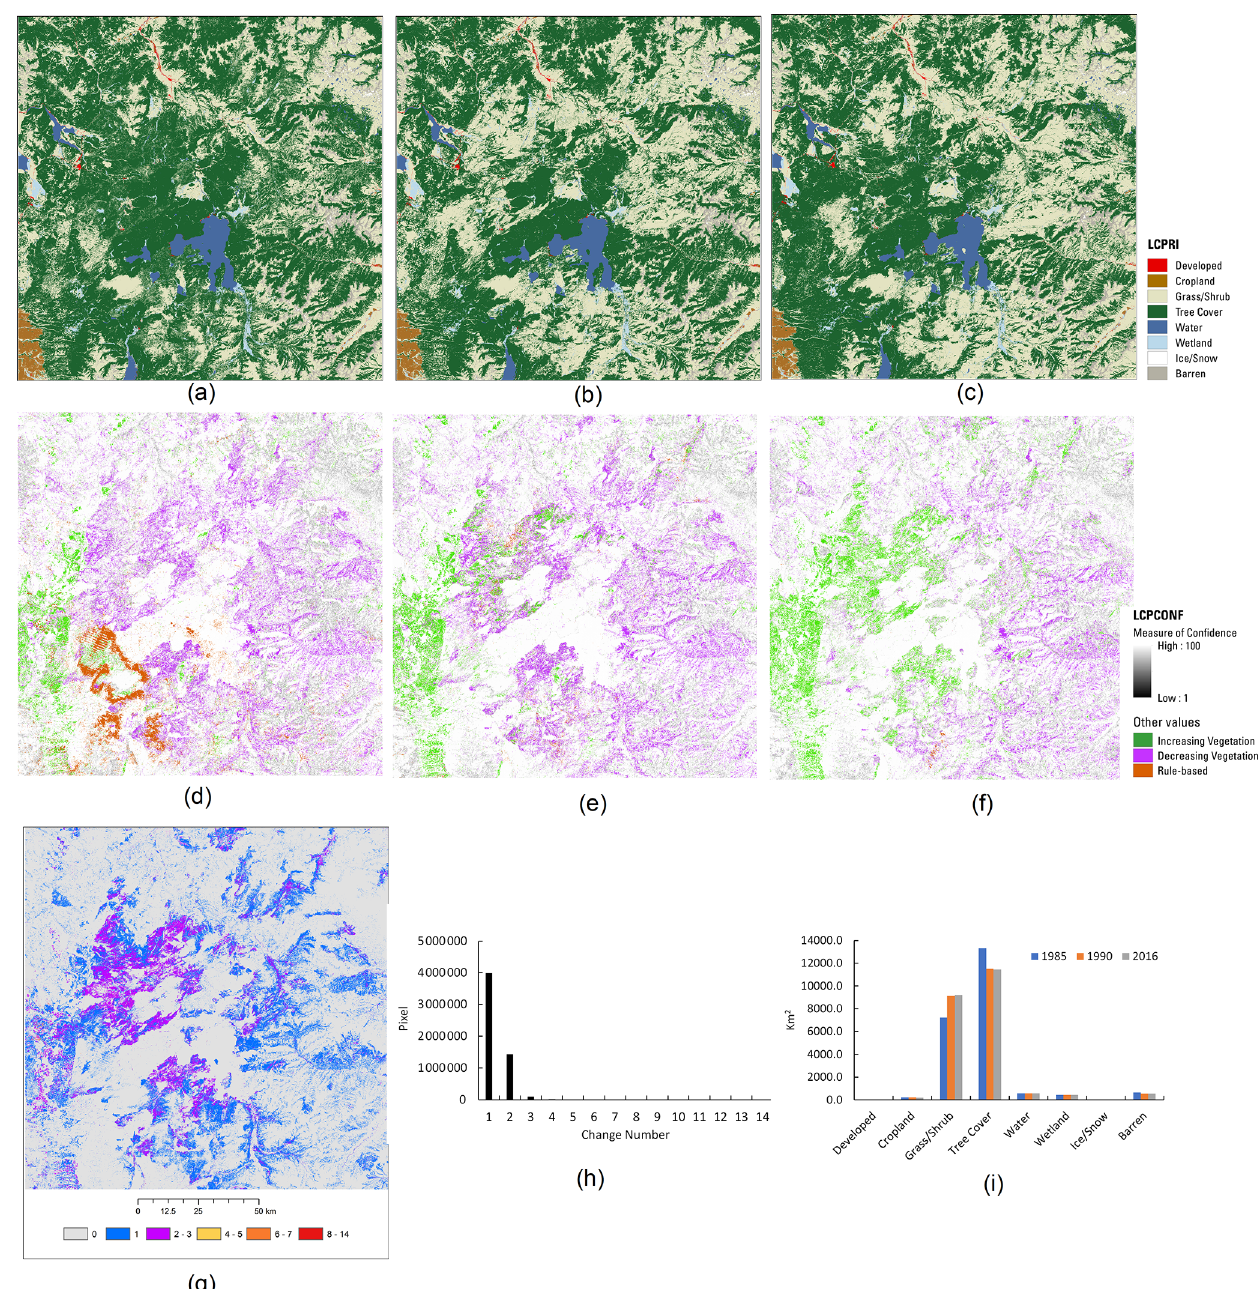
Figure 9. Primary land cover and confidences in 1985 (a, d) , 1990 (b, e) , and 2016 (c, f) and change in 1985–2017 (g) , the frequency of land cover change ( x axis) from 1985 to 2017 and numbers of pixels ( y axis) of these changes (h) , and areas ( y axis) of different land cover ( x axis) in the three times for the ARD tile 9_6 (i)